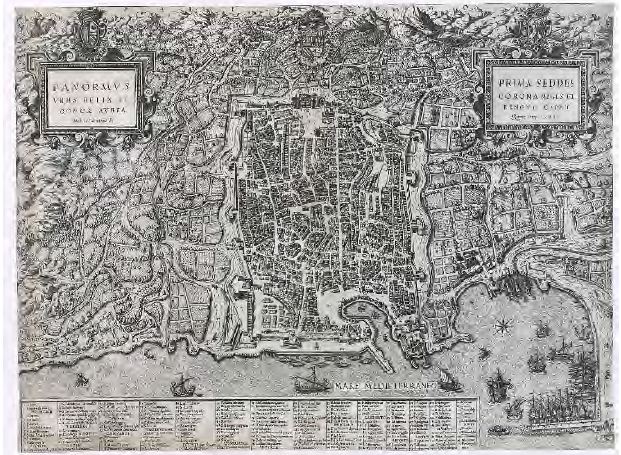
Figure 1. Map of Palermo and of Conca D’Oro by M.F. Cartari – Rome 1581. Right: the Maredolce’s site, thebridge ‘of the Admiral’ (ponte dell’Ammiraglio) and ‘Conca D’Oro’ limits.